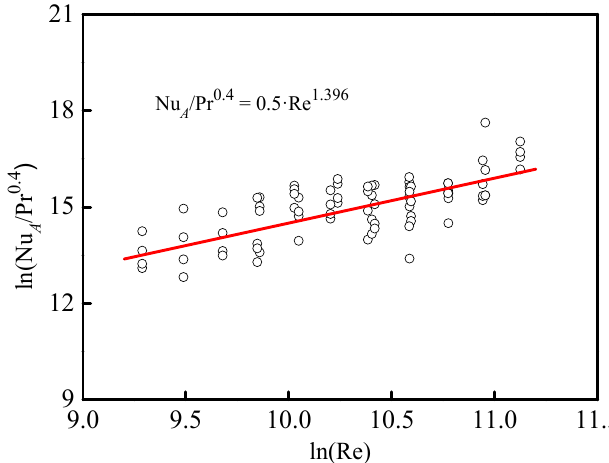
Figure 9. Plot of ln(Nu A / Pr 0.4 ) as a function of ln(Re) for the experimental data.